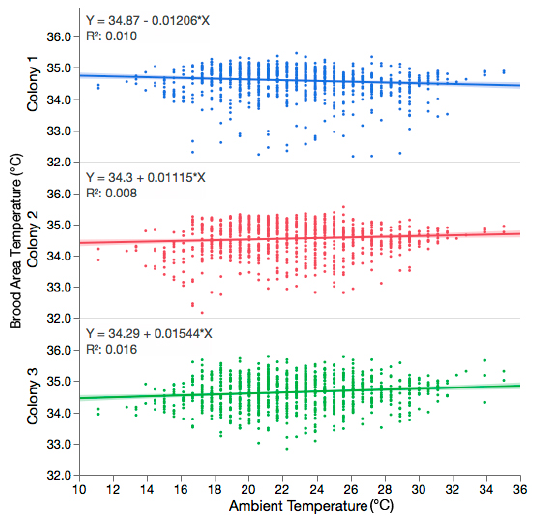
Figure1. Regressionanalysisshowingtherelationshipbetweenobservedhourlybroodareatemperature (Y) and hourly ambient temperature (X) for each colony. There was no significant correlation between observed brood temperature and ambient temperature for Colony 1 (y = 34.87 − 0.01206x, df = 954, r 2 = 0.010, p = 0.0017), Colony 2 (y = 34.30 + 0.01115x, df = 954, r 2 = 0.008, p = 0.0069), or Colony 3 (y = 34.29 + 0.01544x, df = 953, r 2 = 0.016, p <